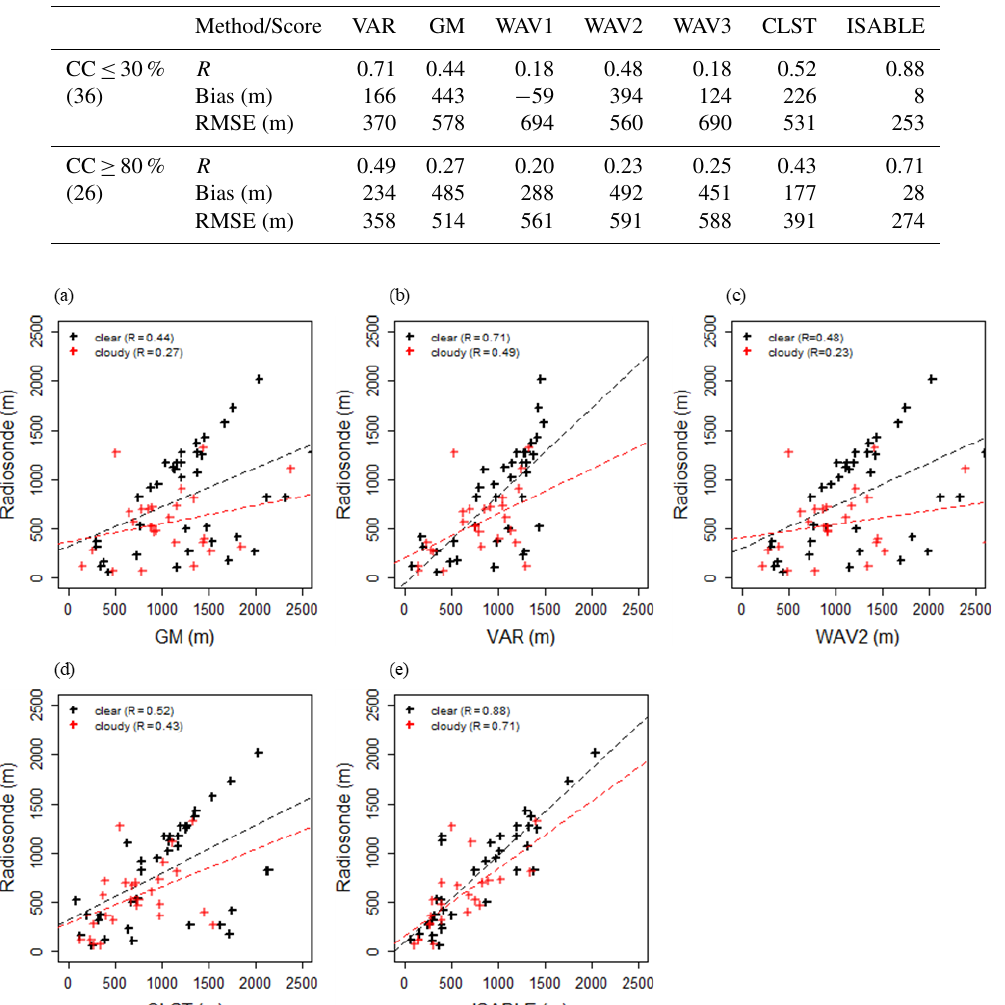
Figure 11. The same as Fig. 10, except that the data herein pertain to clear-sky cases ( N = 36; CC ≤ 30%) and cloudy-sky cases ( N = 26; CC ≥